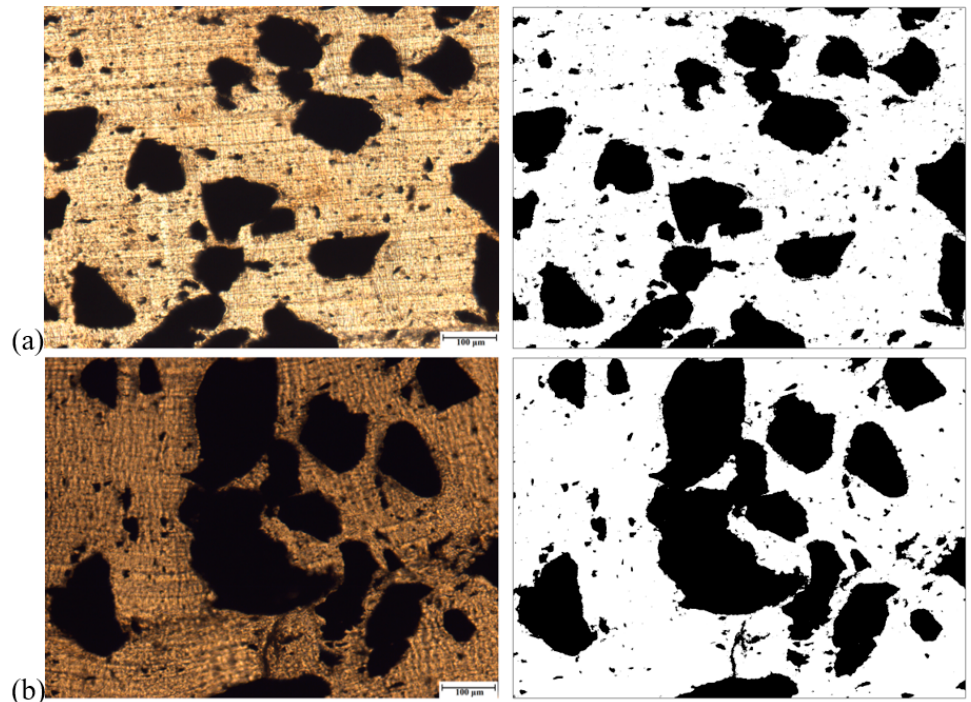
Figure 17. Optical micrographs of PP/EPDM 75/25 blends without ( a ) and with ultrasonic treatment at an amplitude of 13 µ m ( b ) prepared by the OS method (right micrographs were treated by the ImageJ software).